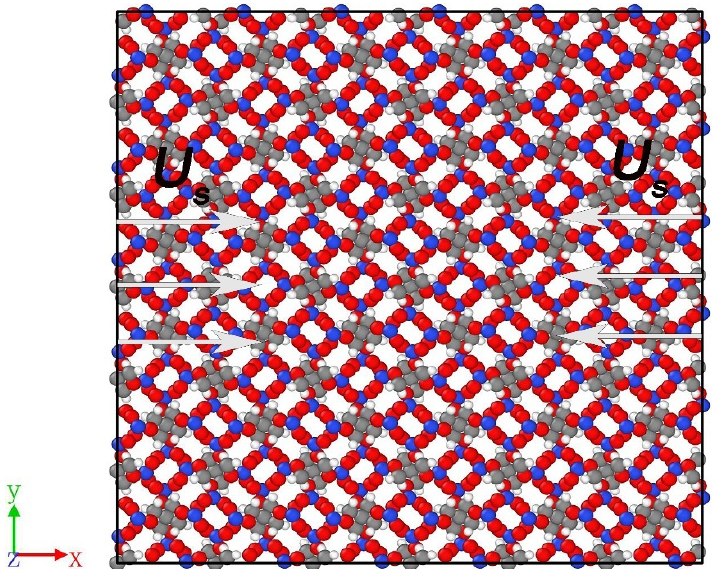
Figure 9. PETN supercell and shock compression model. C, H, O, and N are represented by gray, white, red, and blue spheres, respectively. As is the shock velocity, the arrows point to the shock onset directions, U s = 7 km·s − 1 , 8 km·s − 1 , 9 km·s − 1 , 10 km·s − 1 .